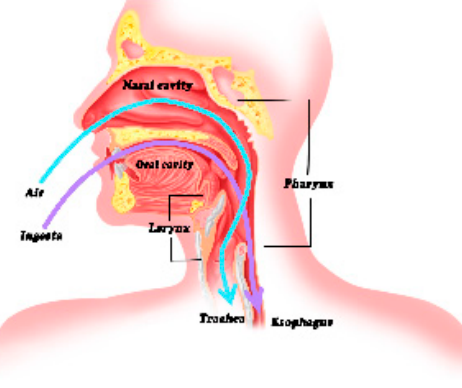
Figure 1. Swallowing pattern diagram.